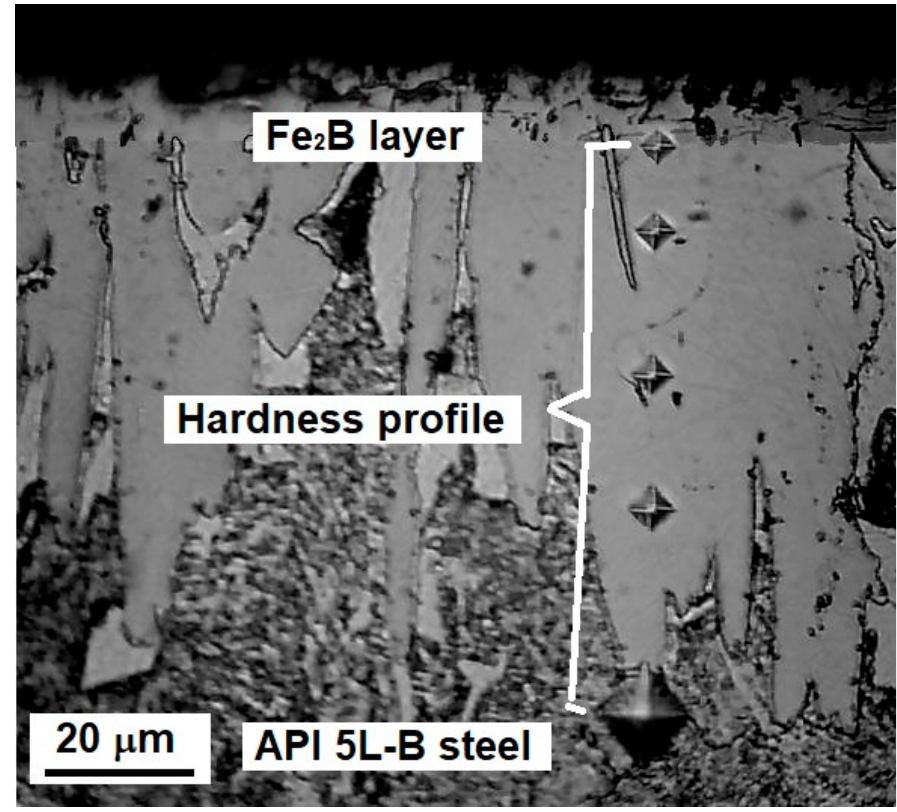
Figure 3. Schematic of the hardness profile measurements.